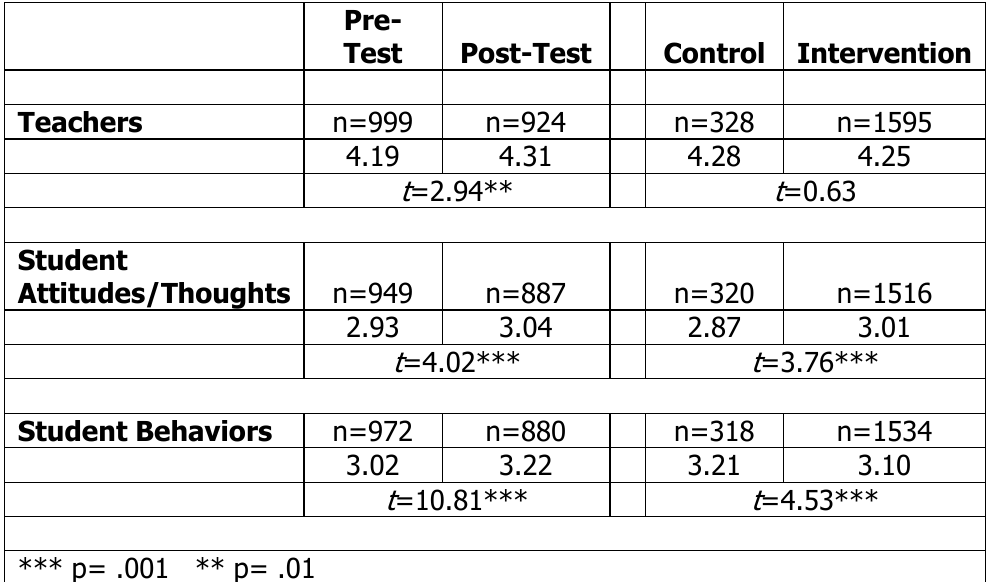
Overall Comparison of T-Test Analysis among Pre/Post-Test Groups and Control Intervention Treatments on Teachers and Student